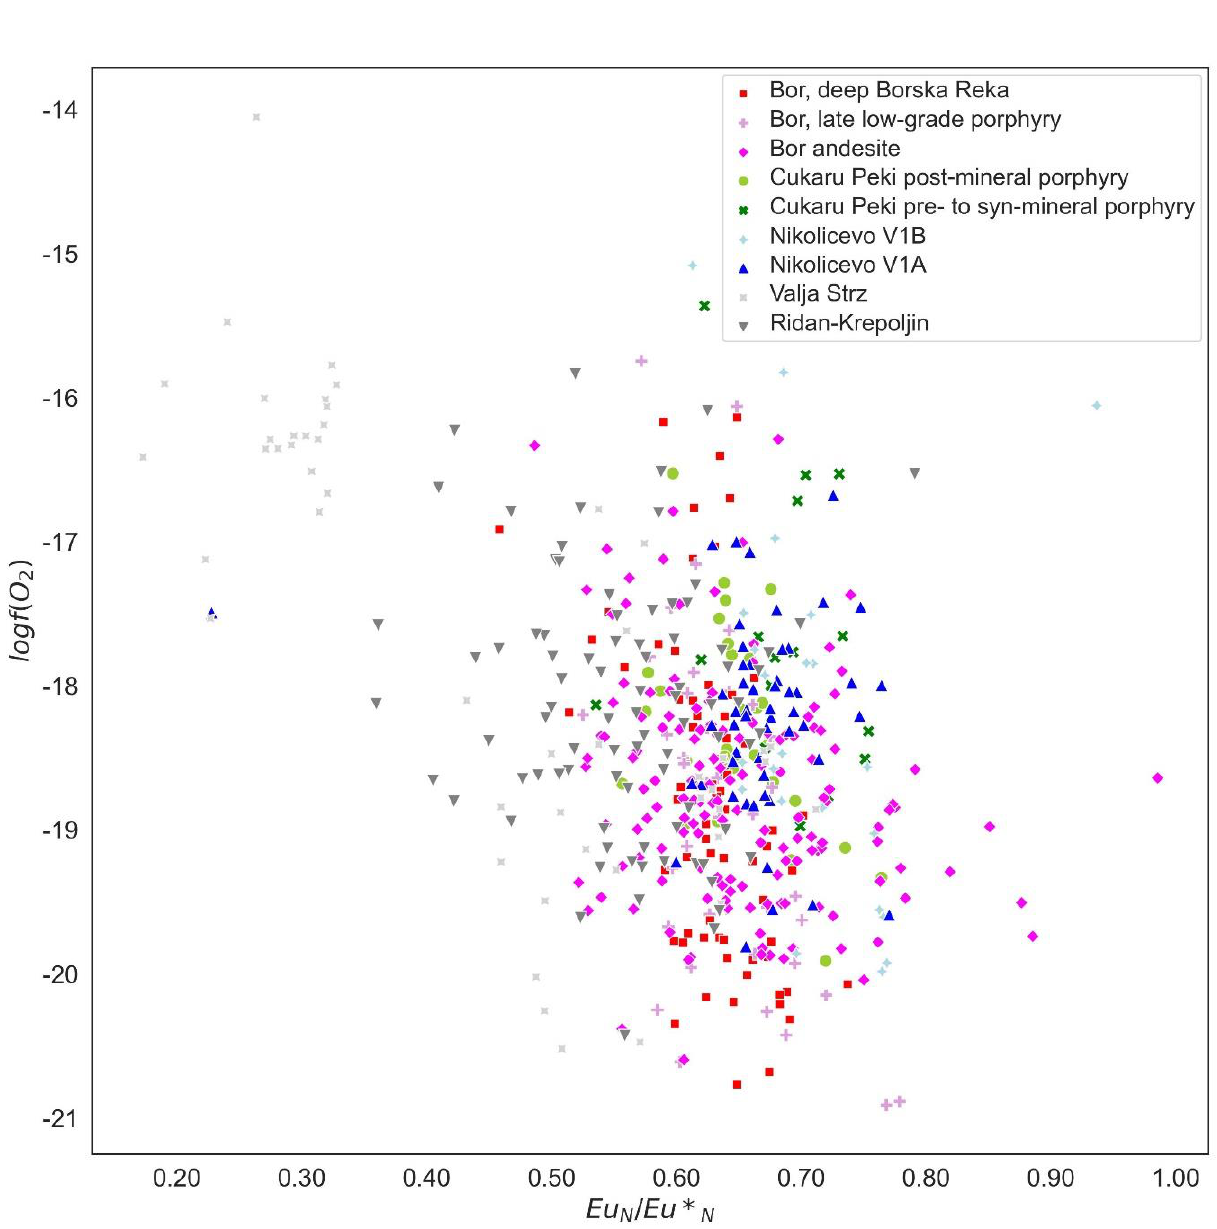
Figure 12. Eu anomaly and calculated oxidation state of magmas according to [59]. Mineralized rocks are characterized by higher Eu anomaly values than barren and weakly mineralized ones.